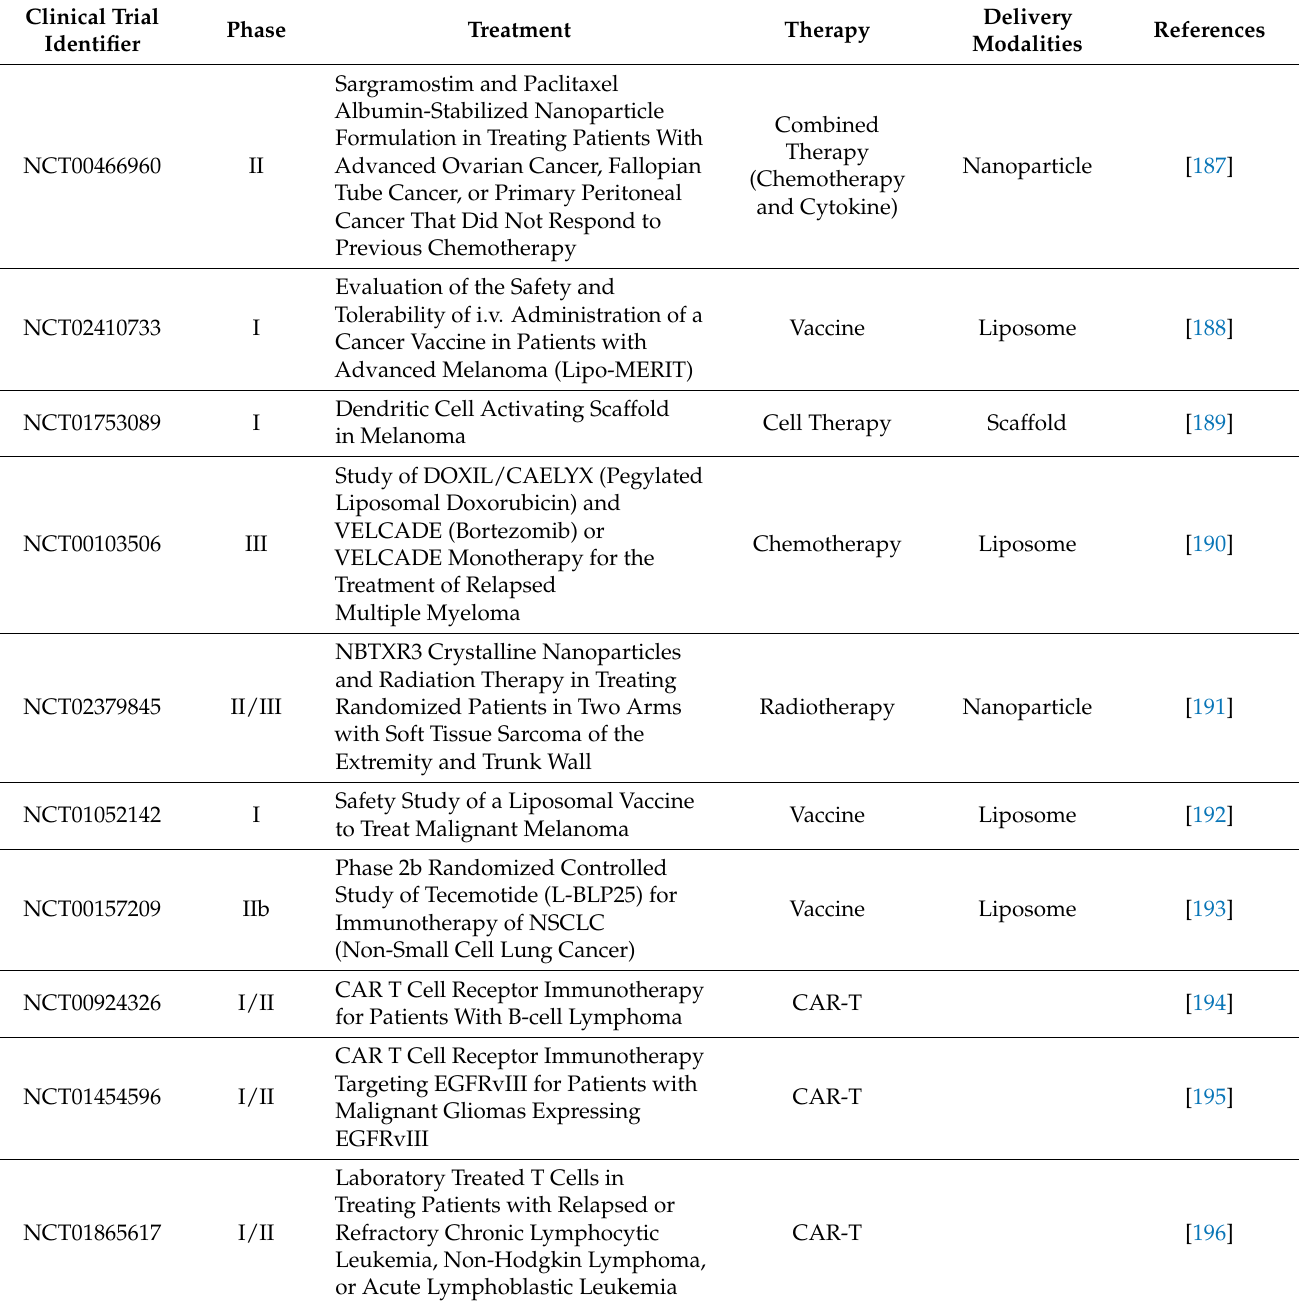
Table 5. Current clinical trials for cancer immunotherapy by various delivery